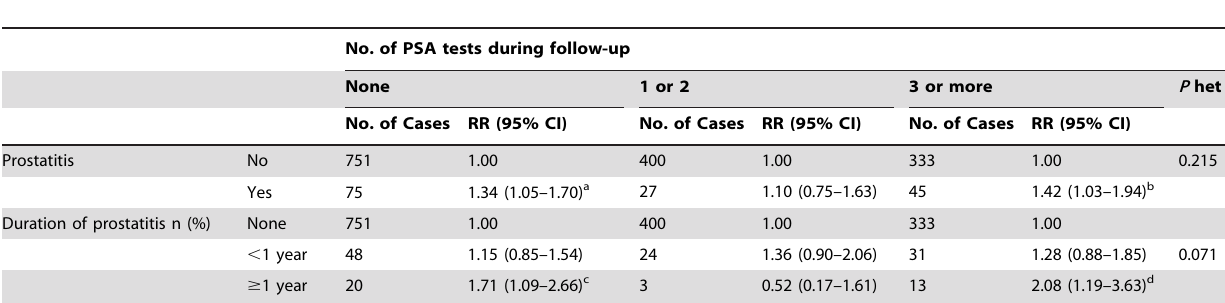
Table 6. Multivariate relative risks and 95% CIs of prostate cancer associated with prostatitis and STD history by number of PSA tests during follow-up, California Men’s Health Study,